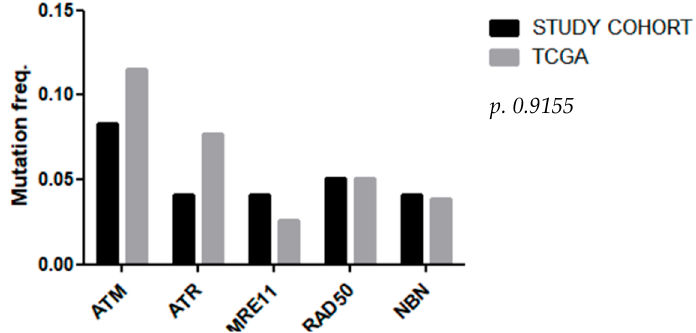
Figure 2. Mutation frequencies of ATM , ATR , MRE11 , RAD50 , and NBN in TCGA data and the study cohort.